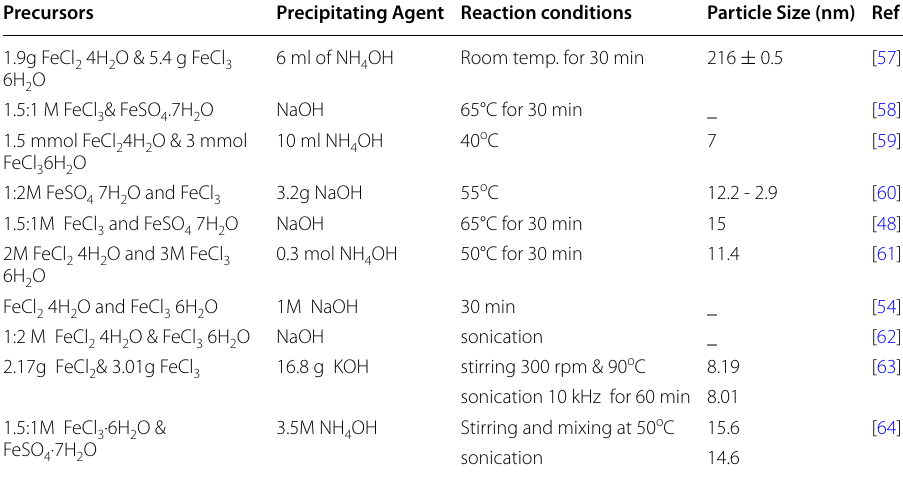
Table 1 Summary of magnetite nanoparticles synthesis by co-precipitation method using Ultra- sonicator